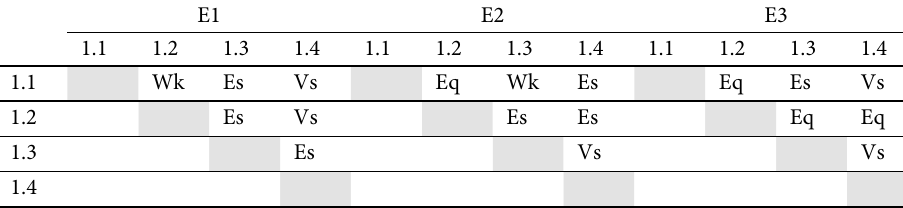
Table 15. DMs’ Evaluation for Alternative with respect to C11